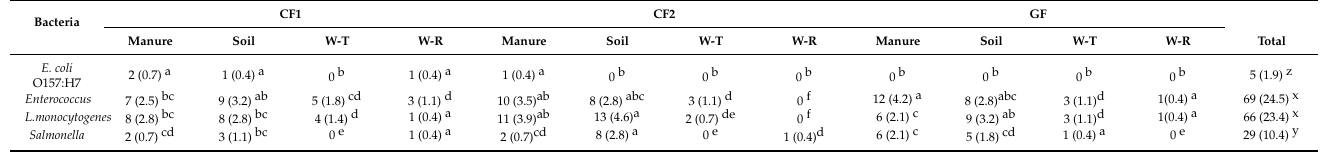
Table 3. Distribution of pathogenic bacteria in cattle and goat farms.